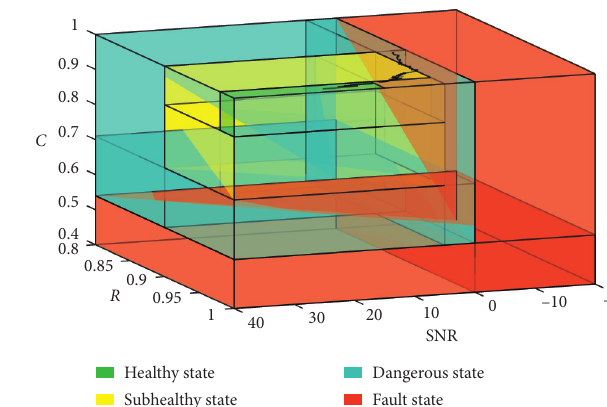
Figure 14: Health grade and health curve in three-dimensional